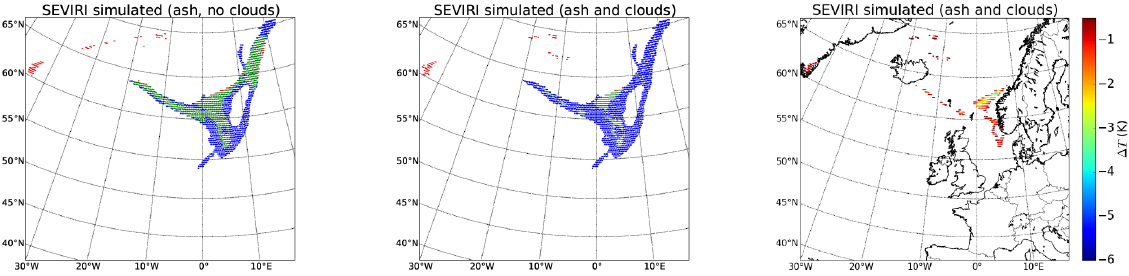
Figure 3. Ash detection: Pixels flagged as ash by the reverse absorption technique in the cloudless simulation (left) and cloudy simulation (centre) compared to pixels with Flexpart ash columns above the low contamination limit (0.2gm − 2 ). The colour coding of the pixels are as follows – coincident (green): pixel identified as ash and contains ash in the Flexpart model simulation; false positive (red): pixel identified as ash, but does not contain ash; false negative (blue): pixel not flagged as ash, but contains ash. (right) The (cid:49)T = T 10 . 8 − T 12 . 0 brightness temperature difference calculated from simulated SEVIRI images with ash and clouds. Only data points with (cid:49)T < − 0 . 5K are shown. Data is for 12:00UTC, 15 April, 2010.